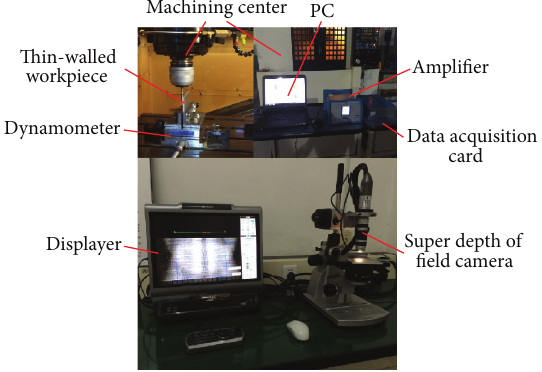
Figure 11: Milling experimental